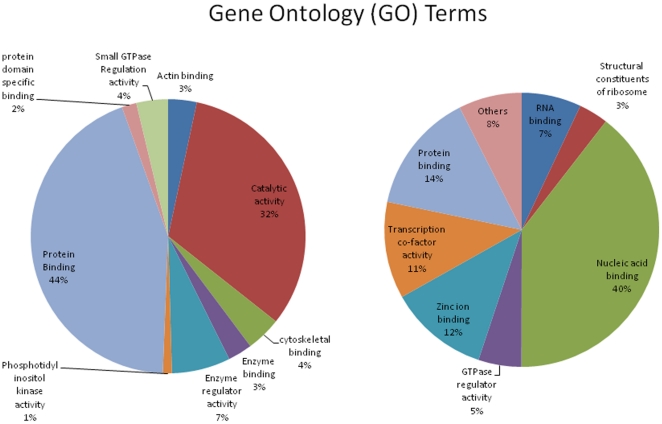
Gene ontology (GO) for downregulated genes (4a) and upregulated genes among the HIV-1 exposed uninfected sex workers.